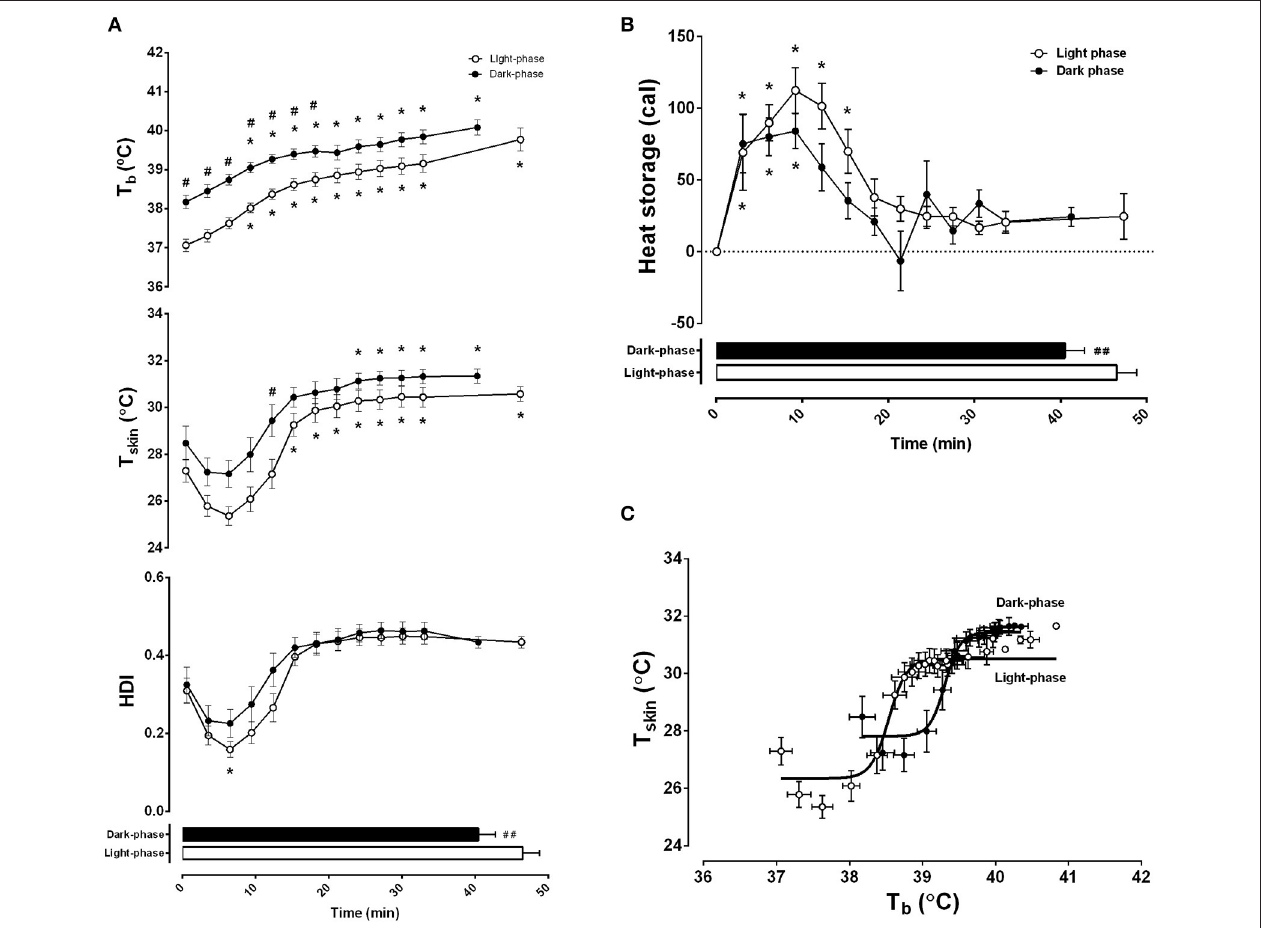
FIGURE 3 | Differences in exercise capacity during the light and dark-phases are associated with changes in thermal balance. Light and dark-phase were represented as white and dark circles, respectively. In (A) , body temperature (T b in ◦ C), skin tail temperature (T sk in ◦ C), and heat dissipation index (HDI) are plotted as a function of exercise duration and performance (horizontal columns). In (B) , 3 min intervals of calculated heat storage are also plotted as a function of exercise duration. In (C) , a nonlinear four-parameter analysis of body temperature and skin temperature is presented as a representation of thermoregulatory effector activity. Best fit curves for light ( r = 0.945, p < 0001) and dark ( r = 0.933, p < 0.001) are presented as solid lines. The results are expressed as the mean ± SEM ( n = 11). *Indicates p < 0.05 against 0 min of exercise; # p < 0.05 and ## p < 0.01 between light and